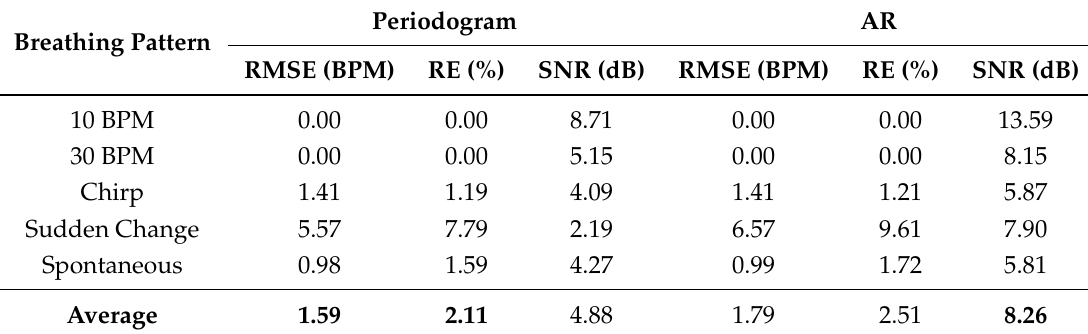
Table 1. Average of five subjects of the results obtained on Dataset